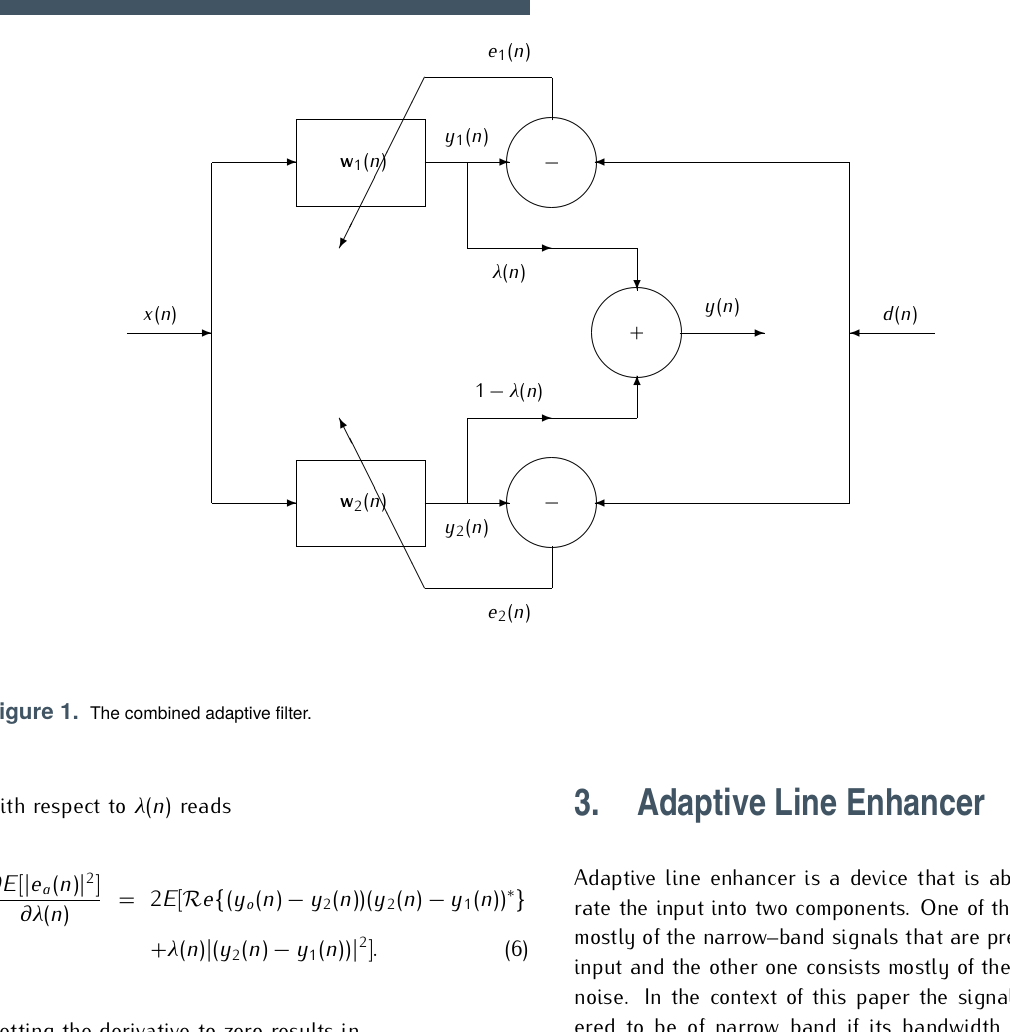
Figure 1. The combined adaptive